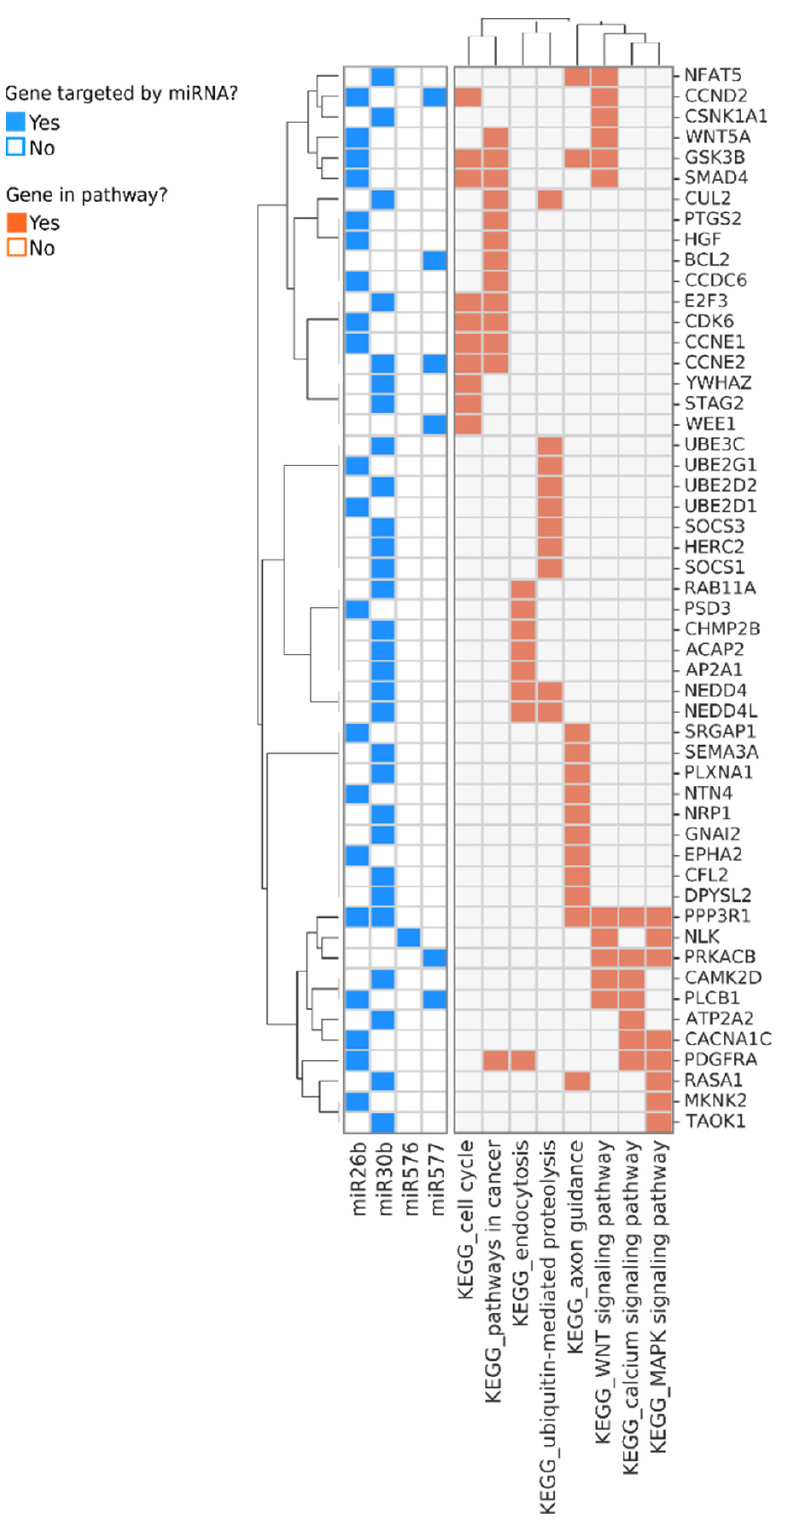
Figure 2. Genes and pathways regulated by the miRNAs that are predominantly or exclusively detected in samples from non-HCC donors. Genes targeted by the miRNAs are shown in rows and the most enriched pathways they participate in are shown at the bottom of the annotation matrix to the right. The annotation matrix to the left indicates the identity of the miRNAs (shown at the bottom left) which regulate each gene.